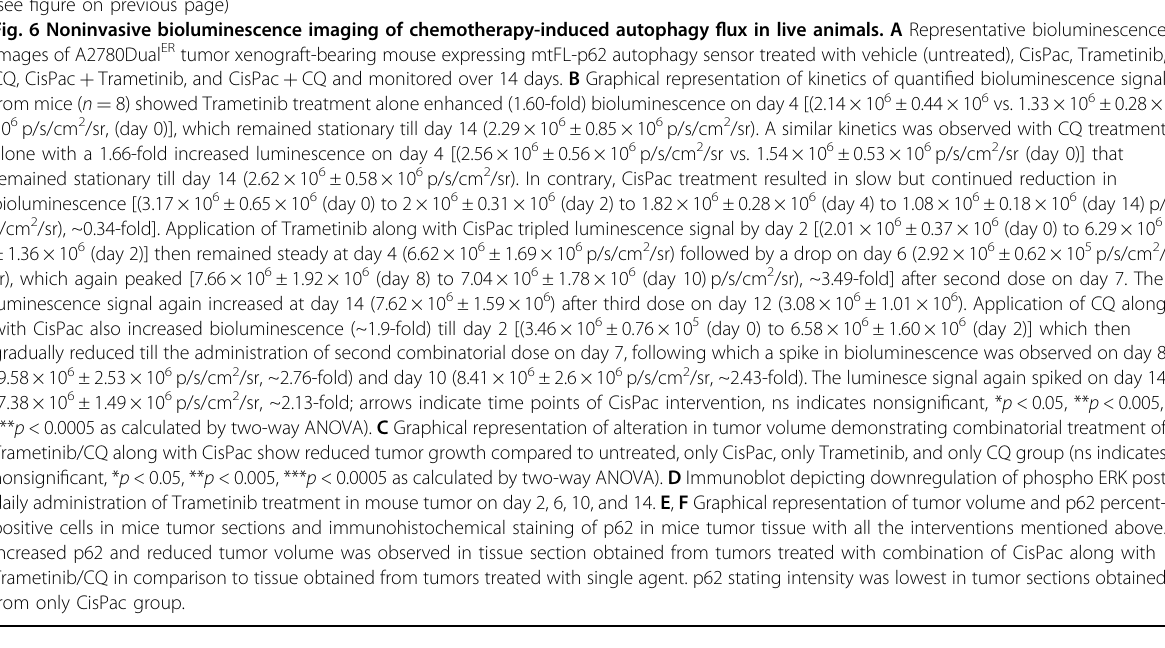
daily administration of Trametinib treatment in mouse tumor on day 2, 6, 10, and 14. E , F Graphical representation of tumor volume and p62 percent- positive cells in mice tumor sections and immunohistochemical staining of p62 in mice tumor tissue with all the interventions mentioned above. Increased p62 and reduced tumor volume was observed in tissue section obtained from tumors treated with combination of CisPac along with Trametinib/CQ in comparison to tissue obtained from tumors treated with single agent. p62 stating intensity was lowest in tumor sections